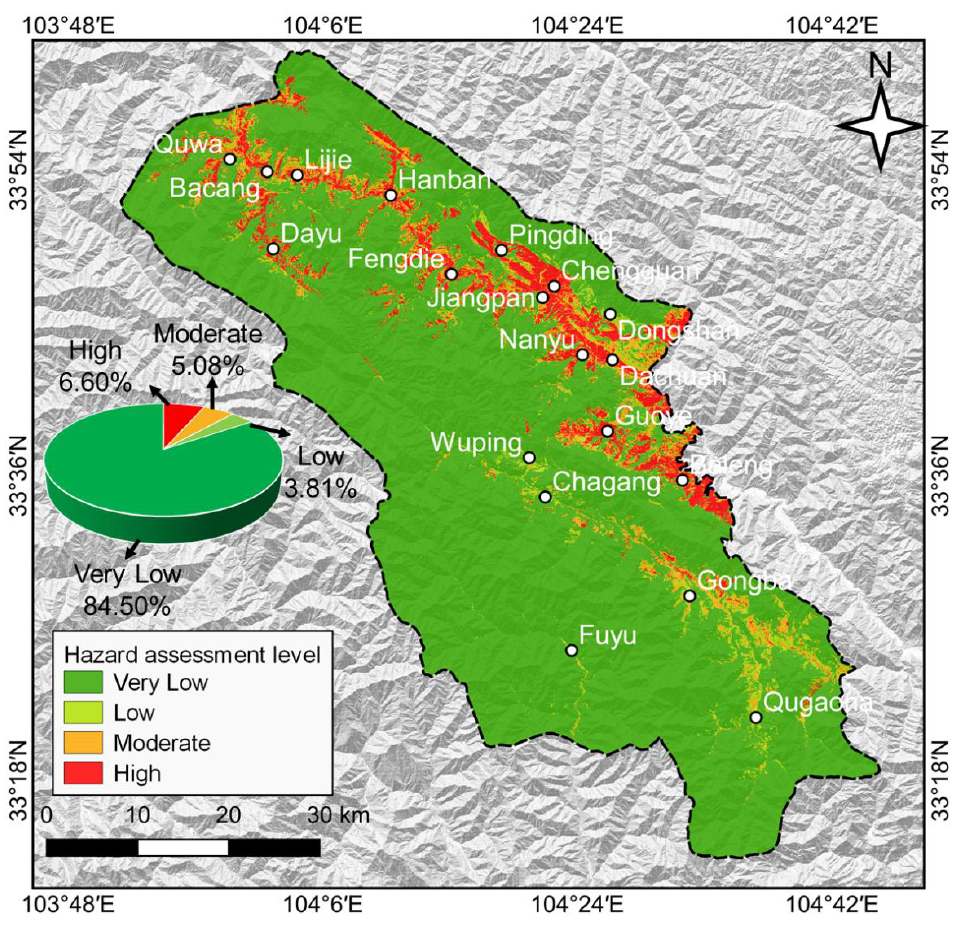
Figure 11. Hazard assessment levels in